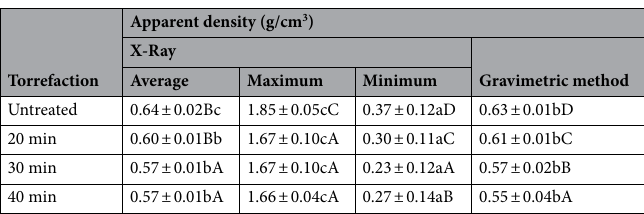
Table 2. Apparent density of untreated and torrefied MDF residues for different times. Means followed by the same capital letter, per column, or lower case, per line, do not differ by the Tukey test (p > 0.05).